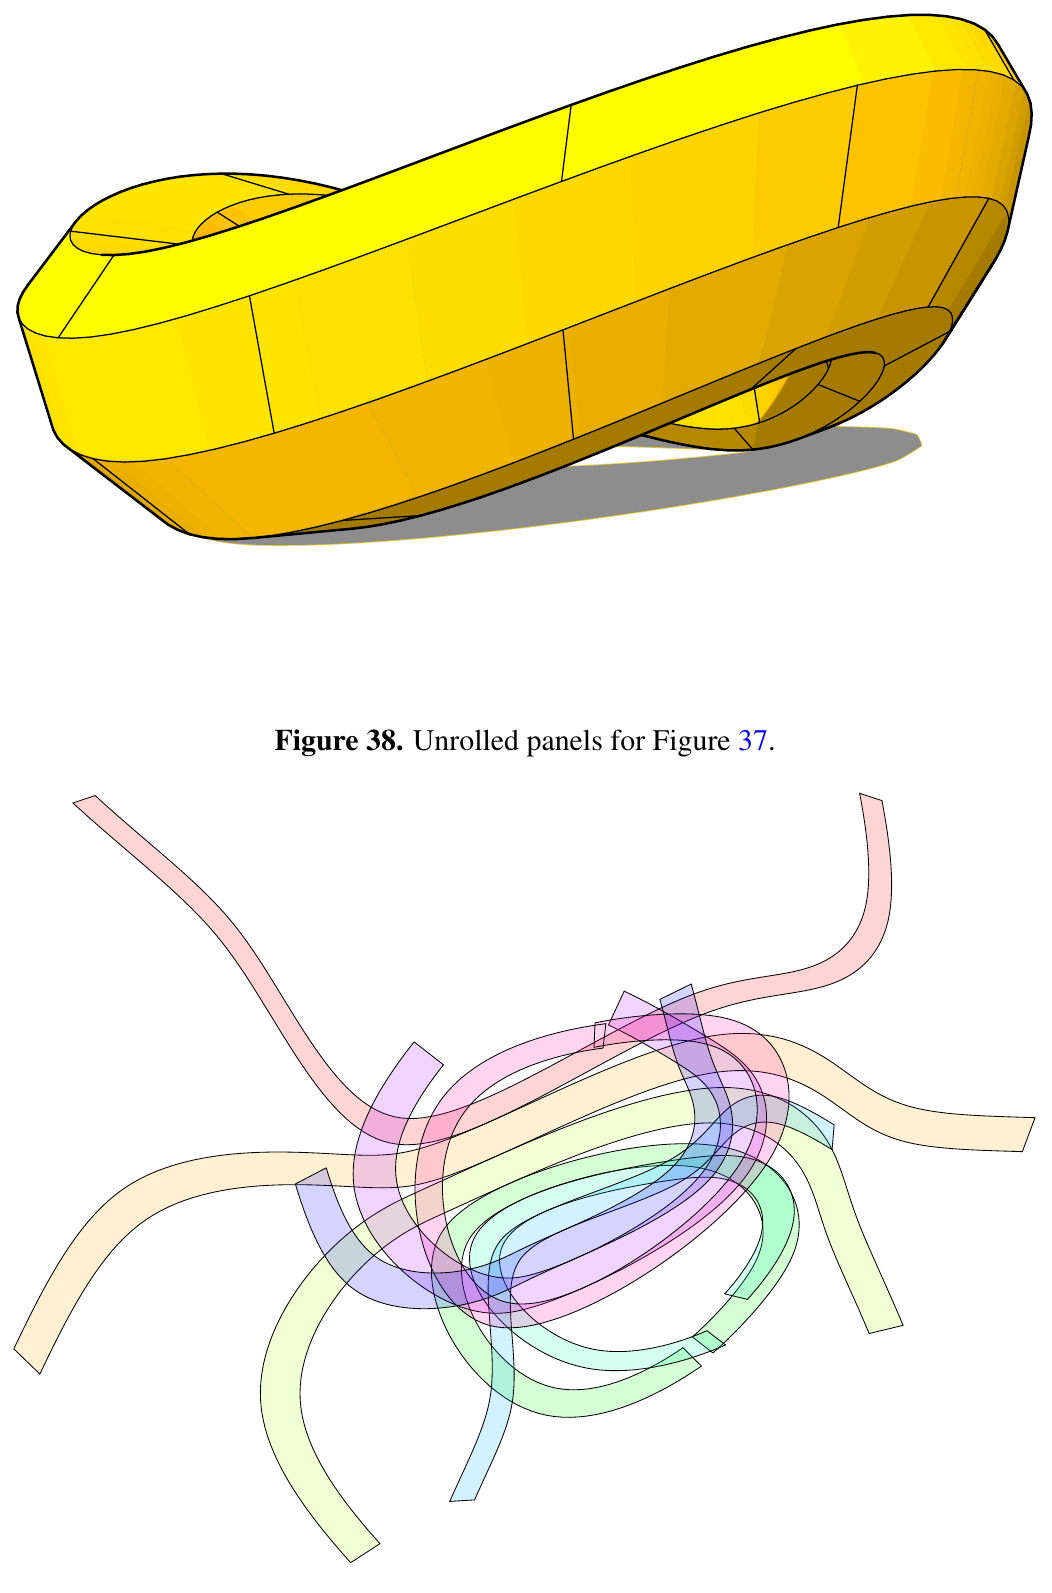
Figure 37. A method four surface in a free-form toroidal shape.